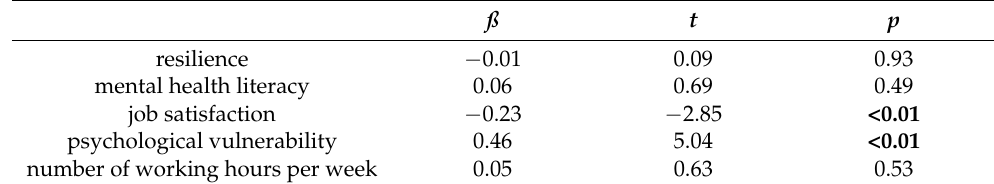
Table 3. Influence of the potential protective and vulnerability factors on municipal workers’ anxiety levels.